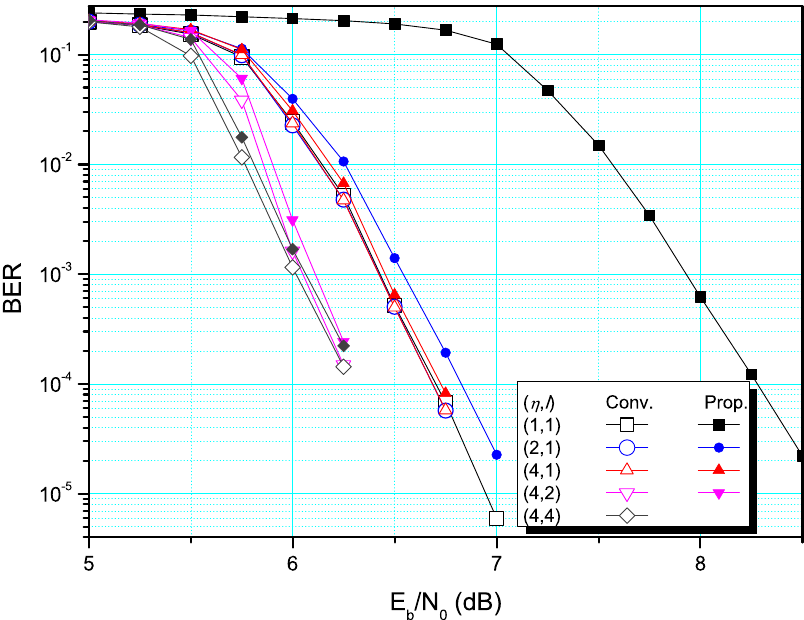
Figure 3. BER performance comparison with various ( η , l ) for 16 × 128 system.